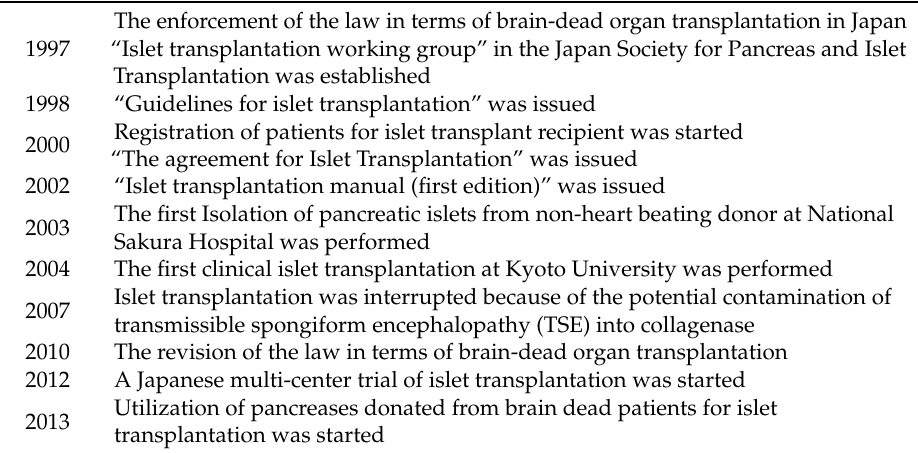
Table 1. The history of pancreas / islet transplantation in